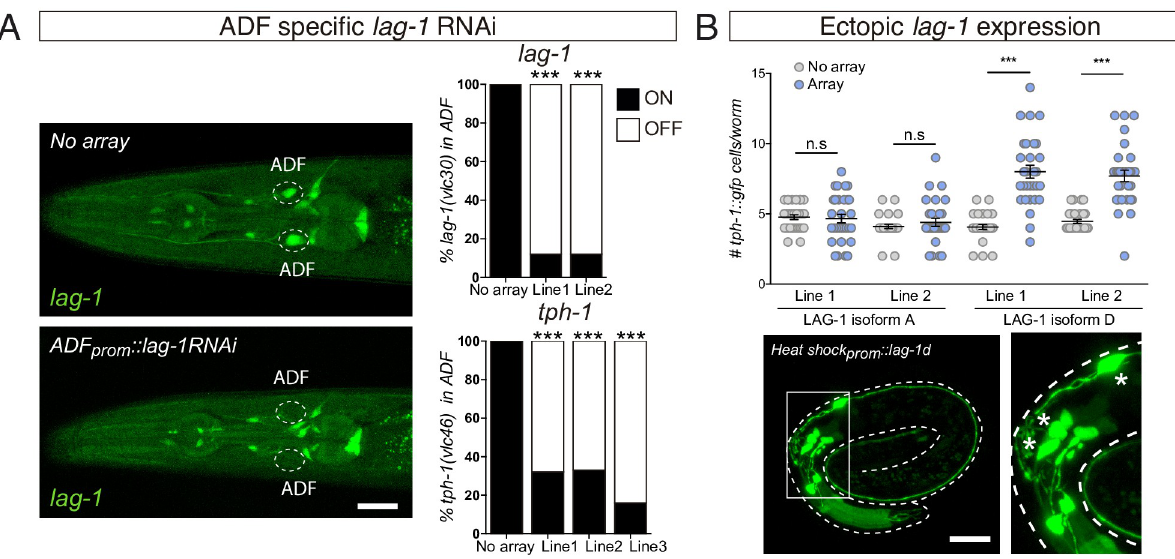
Fig 4. LAG-1 acts cell autonomously in ADF, and it is sufficient to induce ADF effector gene expression. (A) ADF-specific lag-1 knockdown expressing sense and antisense lag-1 under the srh-142 promoter reduces endogenous lag-1(vlc30) and tph-1(vlc46) expression only in ADF, supporting the cell autonomous effect of LAG-1. Young adult images show the specificity of the lag-1 RNAi. Scale bar: 10 μ m. See S1 Data for numerical values. (B) Embryonic ectopic expression of 2 different lag-1 isoforms using a heat shock–inducible reporter. LAG-1D isoform induces ectopic tph-1(zdIs13) reporter expression, while LAG-1A isoform has no effect. Similar effects are observed for 2 independent transgenic lines. n=30. Mean and SEM are represented. Representative micrograph of a lag-1d heat shocked embryo shows tph-1(zdIs13) reporter expression in 7 cells in the head. Asterisks mark ectopic GFP expressing cells. Scale bar: 10 μ m. See S1 Data for numerical values. n.s,